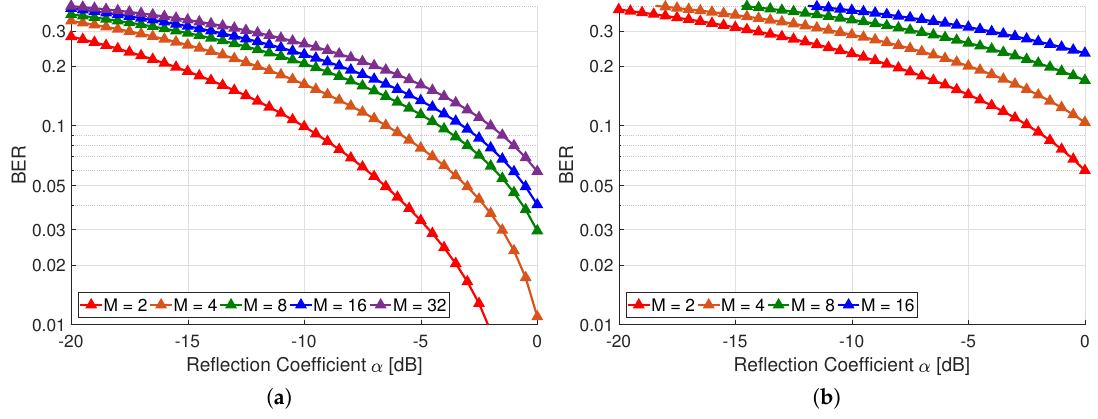
Figure 12. Effect of the modulation order M and the reflection coefficient α for detection and energy harvesting performances (MSC-AmBC: modulation with iterative projections and expansions using ˜ M = 2 impedances, TD-AmBC: M -PSK modulation using ˜ M = 16 impedances). ( a ) BER performance in MSC-AmBC ( K = 10, ζ = 0.16, D = 0.5). ( b ) BER performance in TD-AmBC ( K = 10, ζ = 0.16, D =